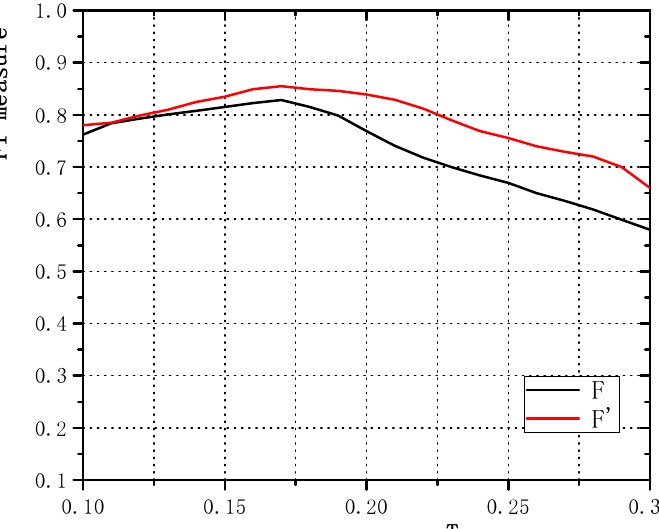
Figure 6. Effects of the parameter T on F1-measure s ( F and F (cid:48) ) for the Type-I RSDDs data